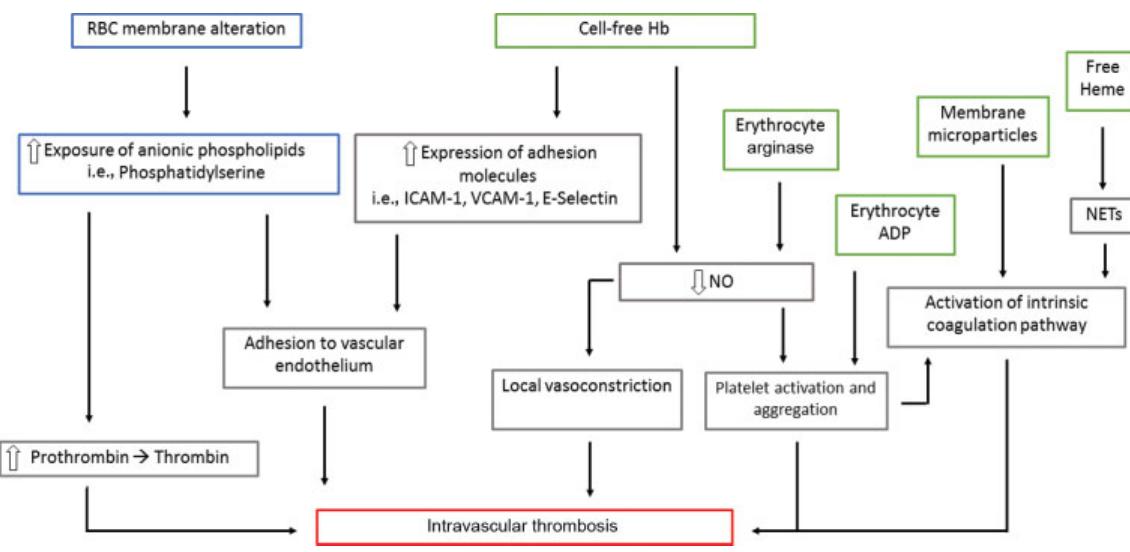
Fig. 2 Postulated model of thrombus formation during hemolysis. Modi fi cation of RBC membrane (blue), release of intra RBC molecules (green). ADP, adenosine diphosphate; Hb, hemoglobin; ICAM-1, intracellular adhesion molecule 1; NETs, neutrophil extracellular traps; NO, nitric oxide; RBC, red blood cell; VCAM-1, vascular cell adhesion molecule